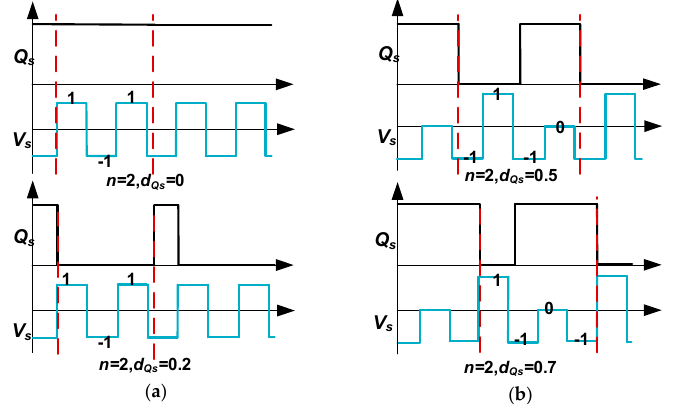
Figure 13. Impact of n and d Qs on the equivalent impedance when n · d Qs is small ( a ) n · d Qs ≤ 0.5 ( b ) 0.5 ≤ n · (1 − d Qs ) ≤ 1.